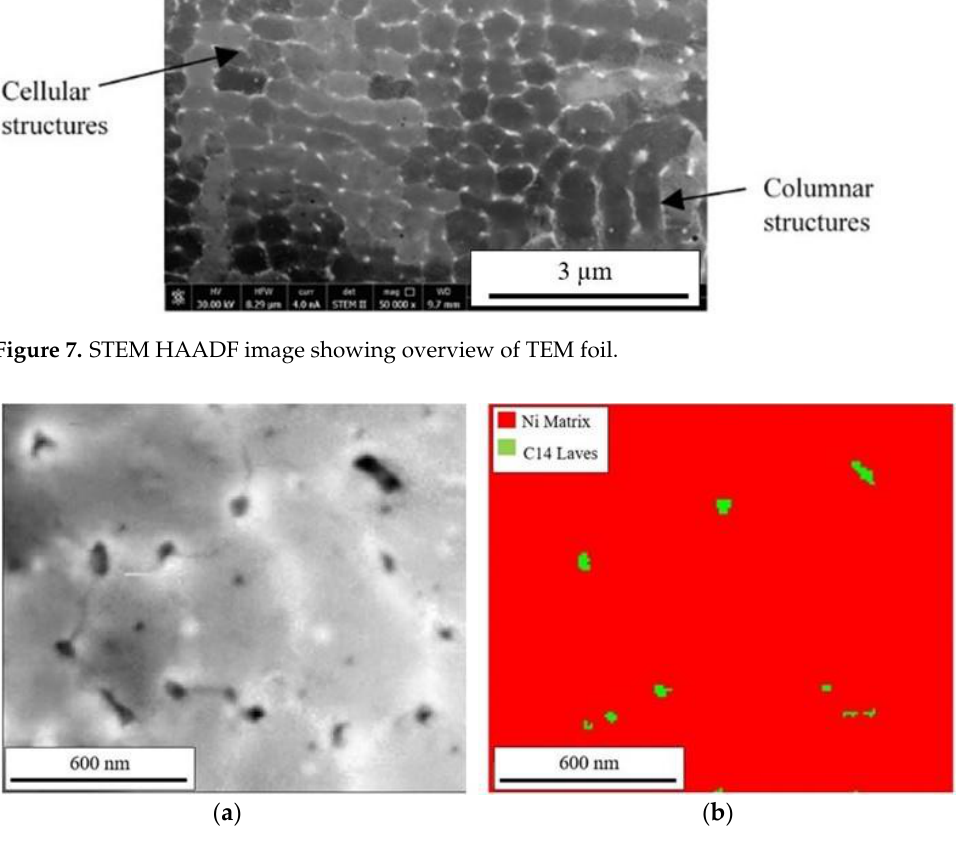
Figure 8. IQ map of cellular structure ( a ) and the corresponding TKD phase distribution map showing the γ (or FCC) matrix in red and the Laves phase in green ( b ).